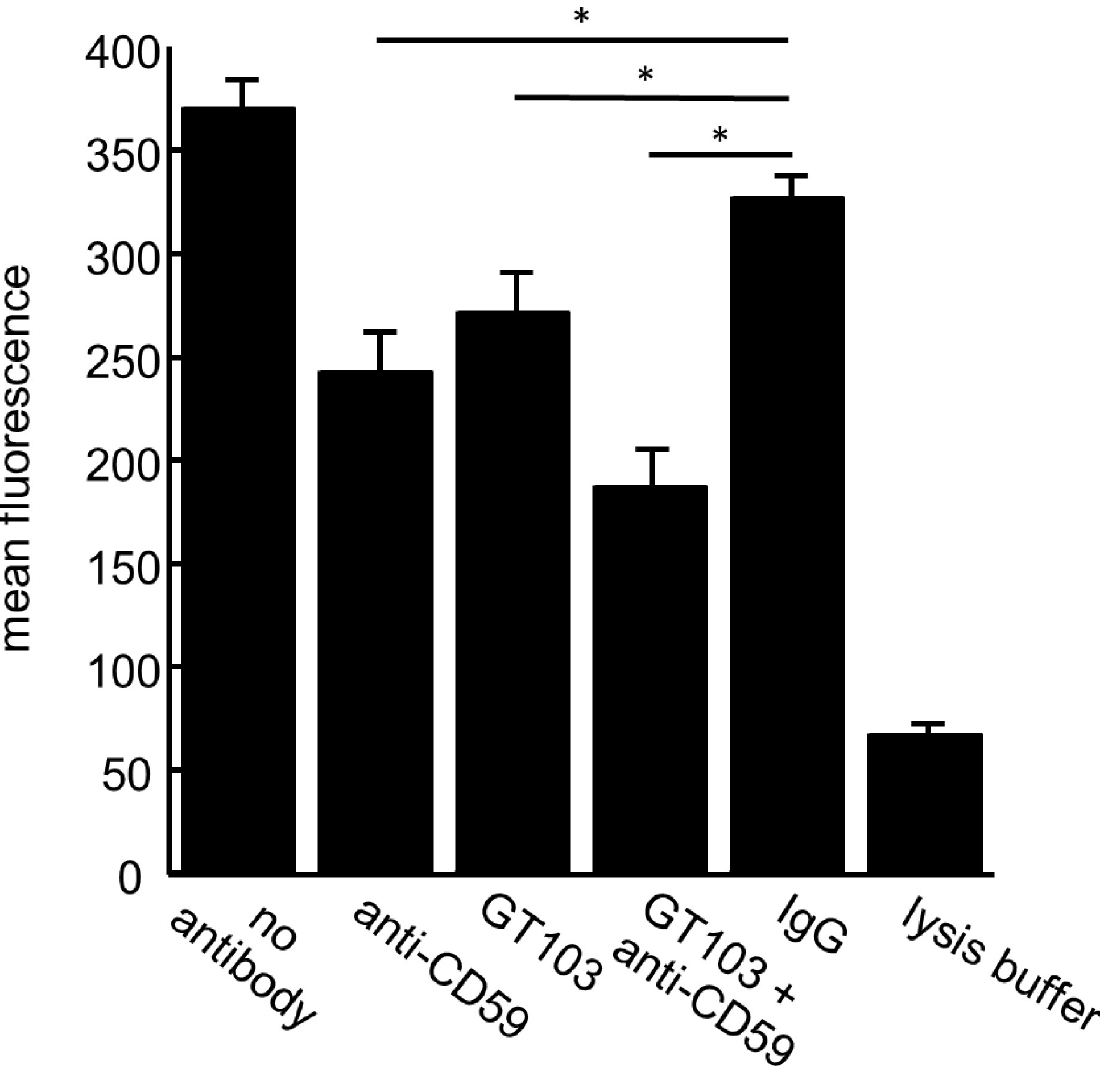
Fig 4. Lysis of human exosomes after neutralizing complement protective proteins. EVs were isolated from the serum of an NSCLC patient using the ExoQuick Ultra isolation kit (System Biosciences). Exosomes were conjugated to CD63 beads and labeled with 25 μ M calcein AM. Exosomes were treated with 50 μ g/ml antibodies in triplicate followed by treatment with 10% NHS as a source of complement for 1 hr at 37 o C. Mixtures were analyzed by flow cytometry. Data are represented as mean +/- SD. � P <